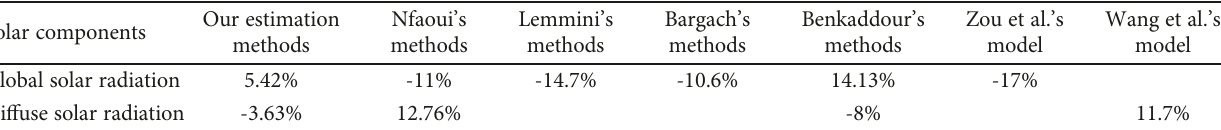
Table 12: Relative errors (RMBE) calculated from the values generated by di ff erent methods of estimation and the measured values. Solar